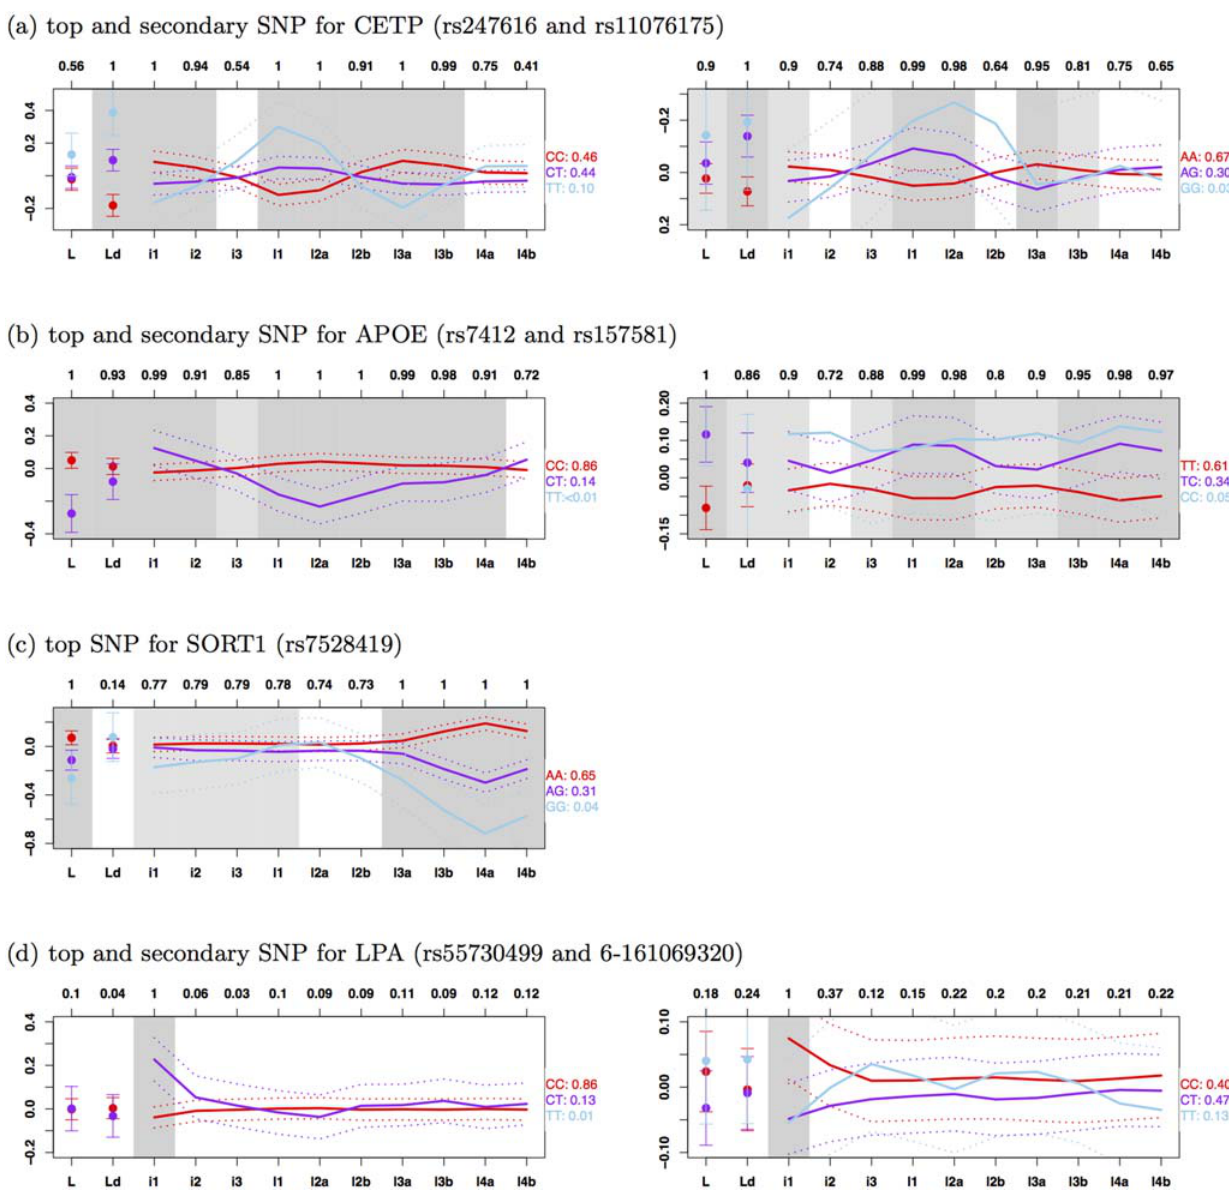
Fig 2. Effects of associated SNPs on LDL subfractions. Solid lines show mean (normalized) phenotype for each subfraction (see Table 1 for abbrevations) by genotype class (reference homozygotes: red, heterozygotes: purple, non-reference homozygotes: sky blue; the proportion of individuals is shown next to the genotype; sky blue lines are omitted if the proportion is (cid:5) 0.01); dotted lines show ± 2 standard errors. Results for secondary SNPs are based on residuals from regressing out top SNPs. Grey shading indicates posterior probability of association (either directly or indirectly) for each phenotype ( > 0.9: dark grey, > 0.75: light grey, < 0.75: white; raw numbers given at top of figure). Note that, because the minor alleles have opposite effects on total HDL-C at the two SNPs in CETP, the y -axis is reversed for the secondary SNP to emphasize the similar shapes of the curves.